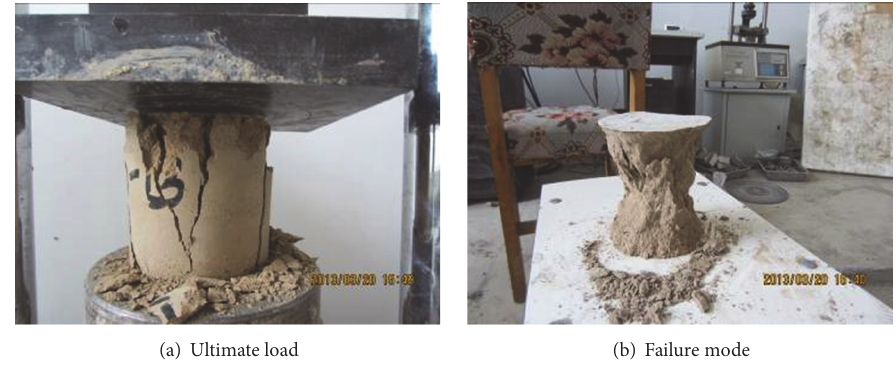
Figure 3: Raw soil, cement soil, and lime soil specimens.